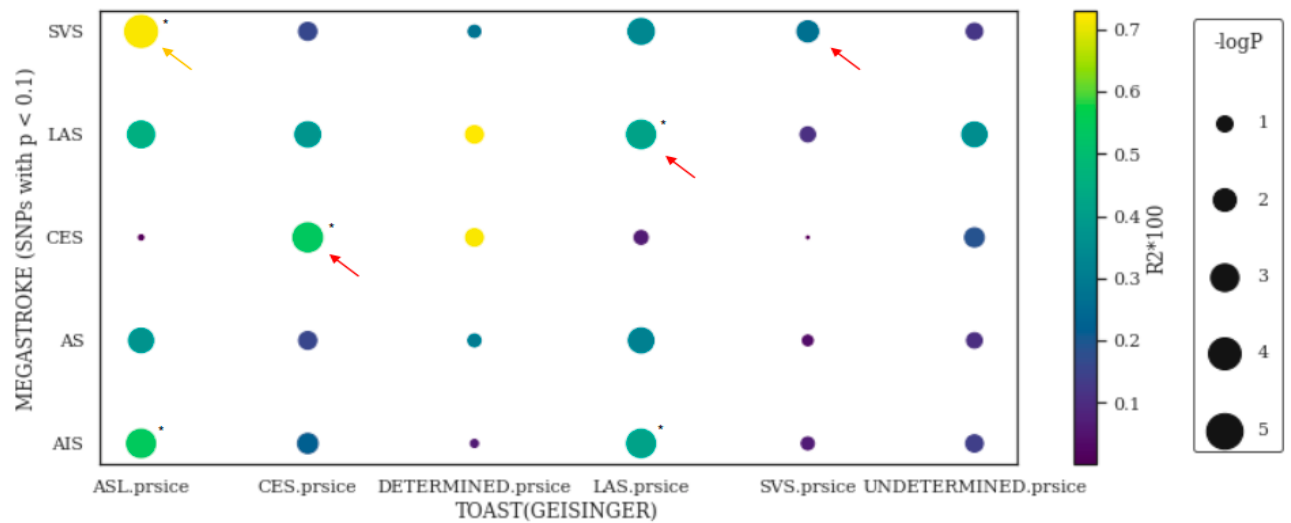
Figure 4. The PRS derived from MEGASTROKE subtypes was mostly associated with the corresponding Geisinger TOAST subtypes. The dot plot demonstrates the association of PRS derived from MEGASTROKE on Geisinger TOAST subtypes when using base p < 0.1 as an example . The association between PRS and stroke subphenotypes was tested by logistic regression (Phenotype ~ PRS avg + Sex + PC 1–5 ). The PRSs derived by the MEGASTROKE consortium (y-axis) was calculated by PRSice-2 to determine their association with the TOAST subtypes of Geisinger ischemic stroke patients ( x -axis). Nagelkerke pseudo- R 2 (color of dots) and significant levels (size of dots) were calculated by PRSice-2 with clumping and thresholding (using SNPs with base p < 0.1 as an example). “*” represents the significance of the association surviving Bonferroni correction given 30 paralleled testing (P unadjusted < 0.0017)”. We excluded any cases with a recurrent stroke of different TOAST subtypes. CES, cardiac embolism; DETERMINED, stroke of other determined etiology; LAS, large artery stroke; SVS, small vessel stroke; UNDETERMINED, stroke of undetermined etiology; ASL, a synthesized TOAST subtype, which represents a combination of Acute SVS ( n = 79) and LAS ( n = 124); AS, any stroke; AIS, any ischemic stroke. This figure adapted from Li J (2021) [24] with CC BY-NC-ND.